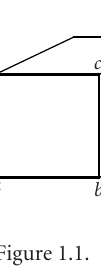
Figure 1.1. Cube